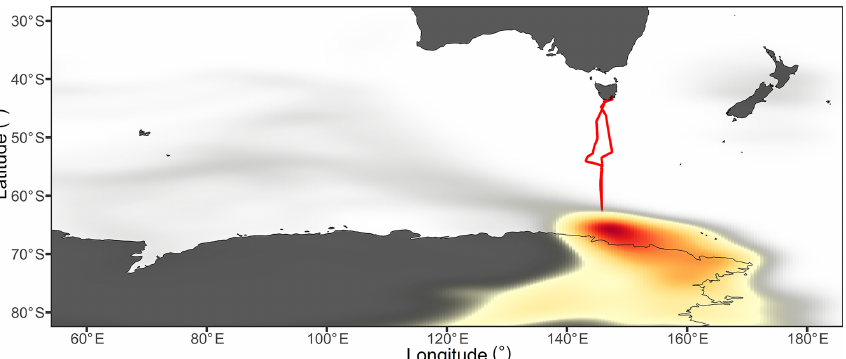
Figure 9. Probability distribution of air mass coordinates throughout all back-trajectory ensembles from the cAA-I sampling period. The colour scale reflects the proportion of trajectories which passed through each location, with the highest density of trajectories found in the dark red region. The ship’s voyage track is represented in red and the ship was located at a mean latitude of 64.5 ◦ S during this period.